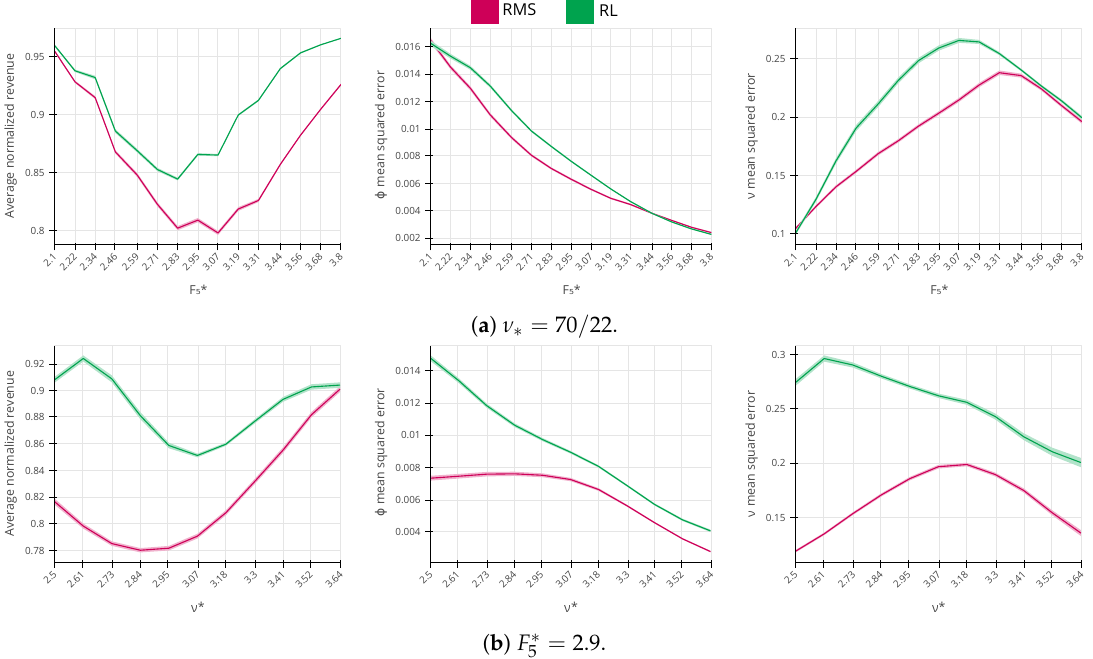
Figure 9. The comparison between the average performance of the revenue management system, reinforcement learning, and revenue-maximizing policies (99% confidence